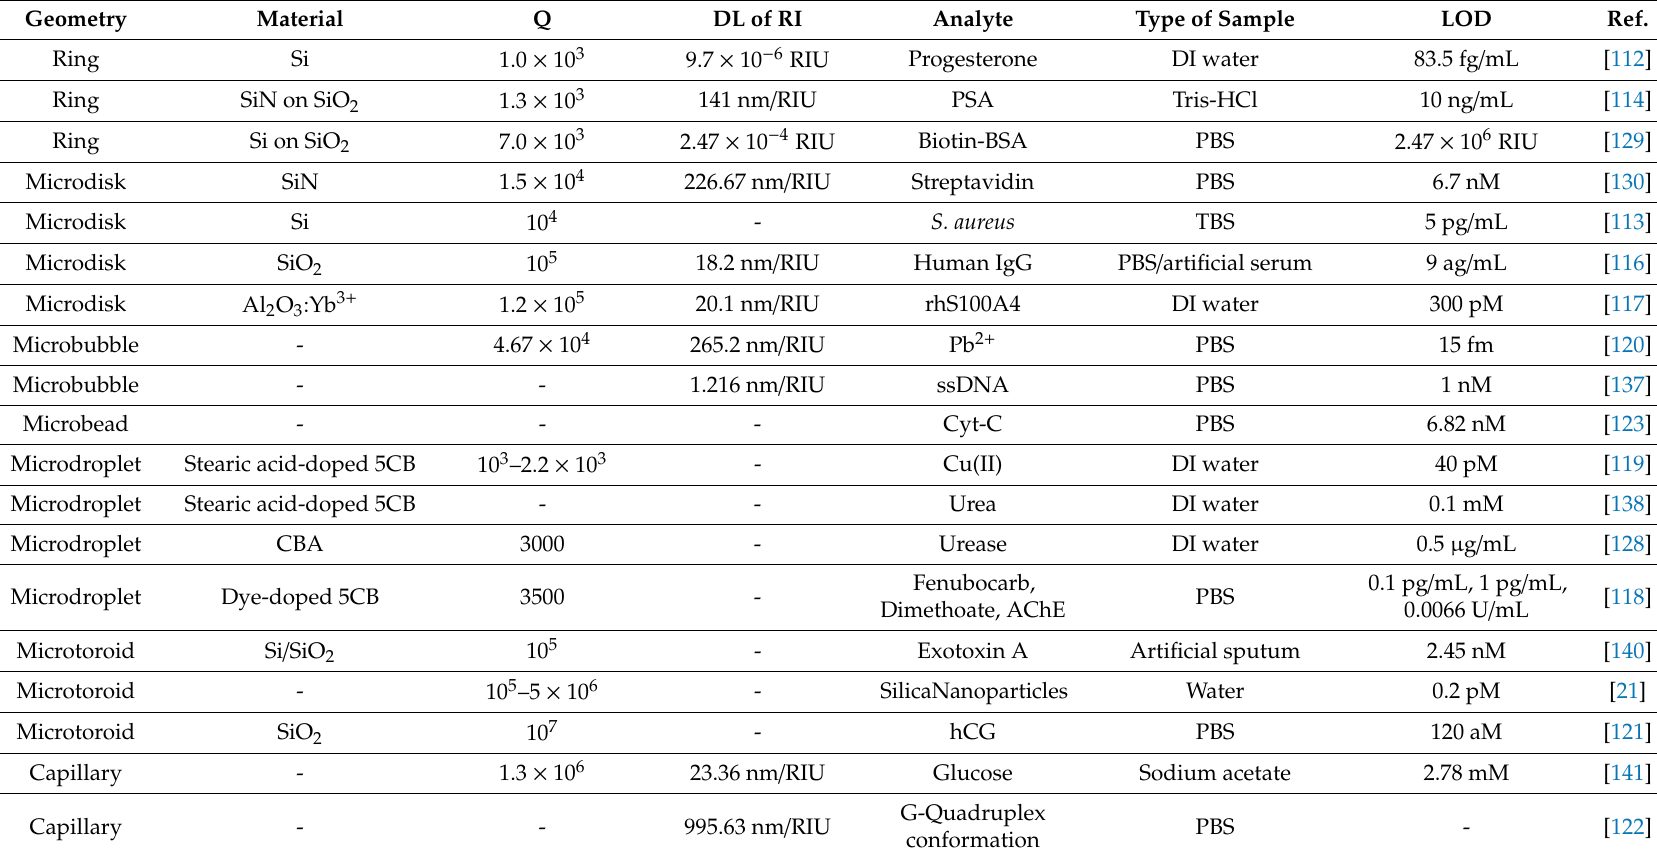
Table 3. Summary of WGM-based